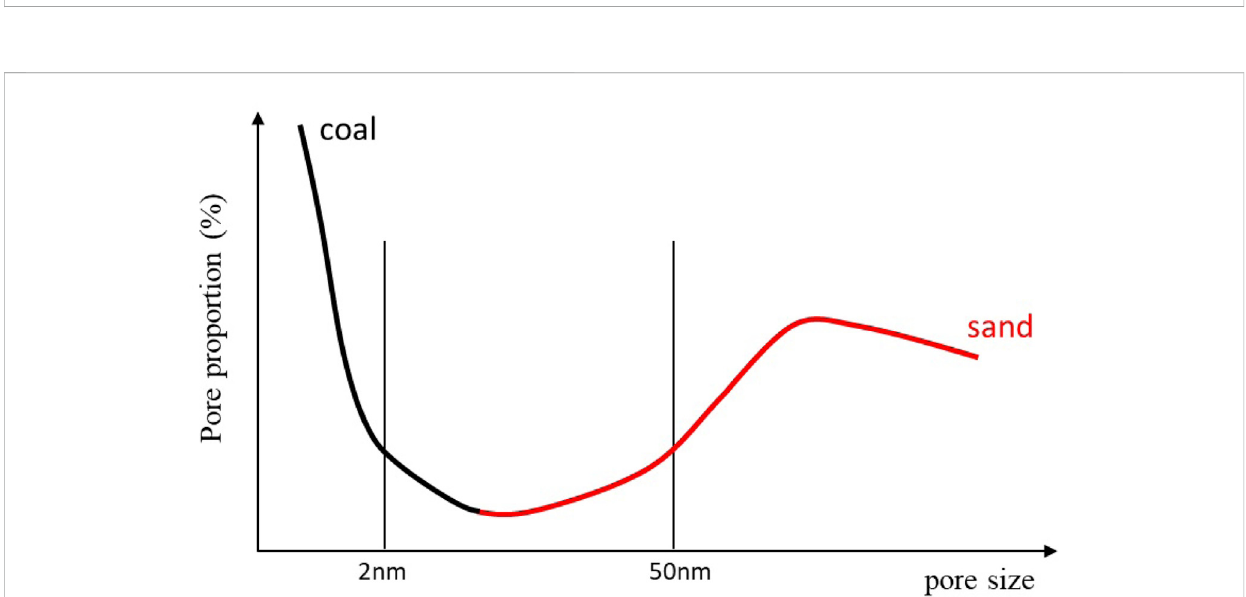
FIGURE 4 V-type curve of pore distribution for sandstone – coal association in Ordos